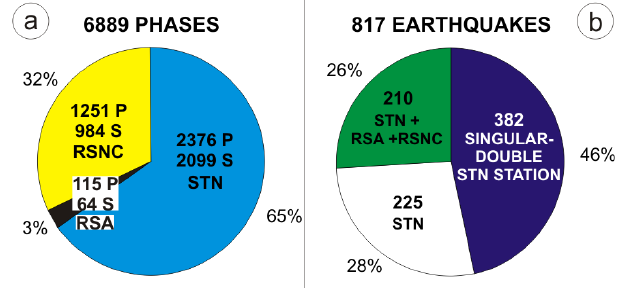
Fig. 4. Meta data obtained by the STN network in the first seven months. (a) Total number of seismic phases obtained after the inte- gration of STN data with those from regional (RSA) and national (RSNC) permanent networks. (b) Total number of earthquakes rep- resenting our complete data